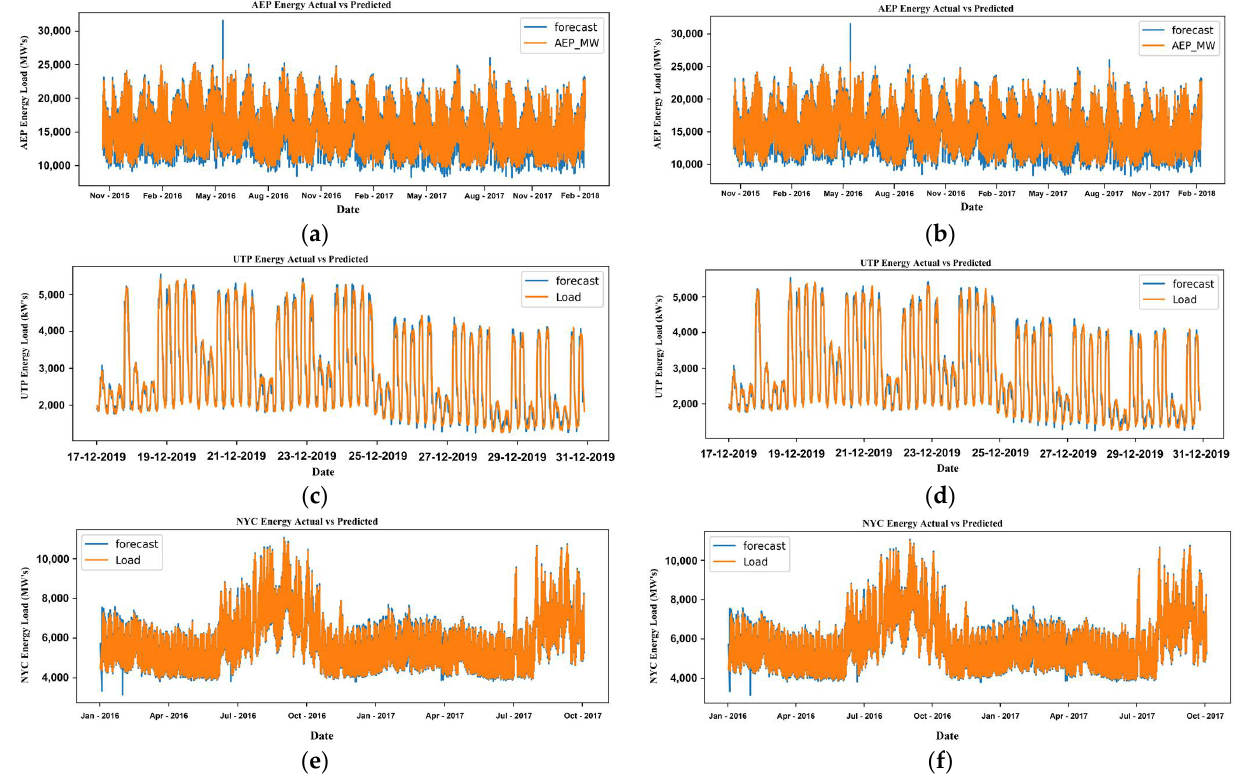
Figure 13. Actual and predicted results of A.E.P. ( a , b ), U.T.P. ( c , d ), and N.Y.C. ( e , f ) before and after parameter variation in provided dataset and forecasting model ARIMA.